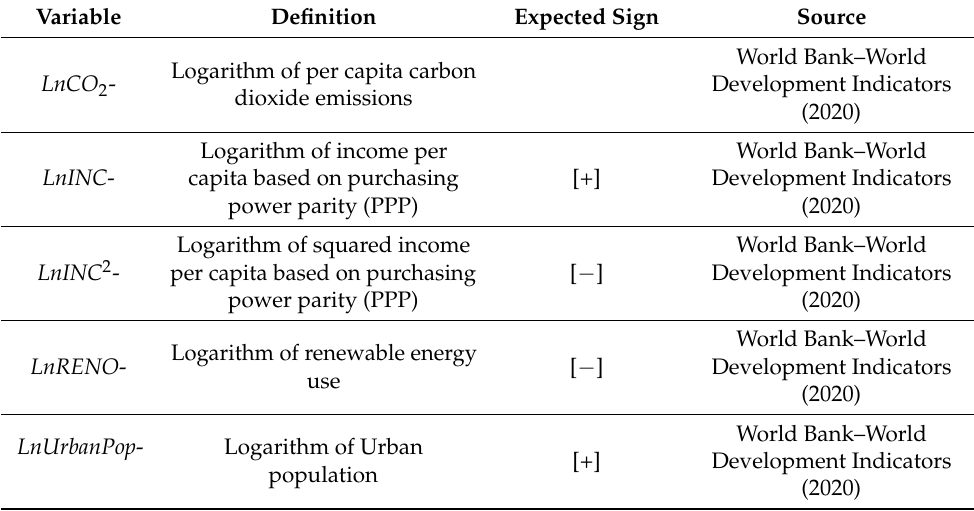
Table 1. Definitions of variables and expected